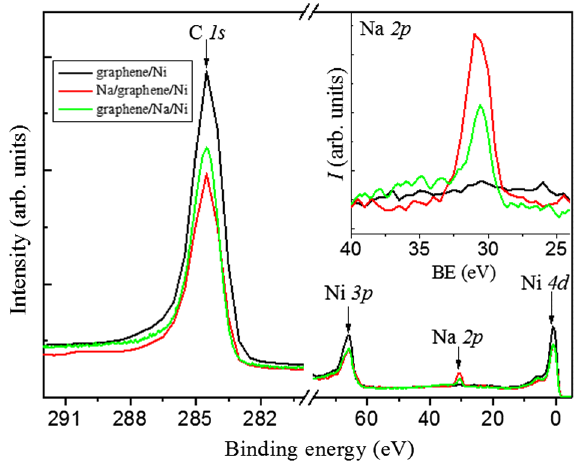
FIG. 8. Core-level PES spectra of the graphene grown on the Ni surface taken with a photon energy of 360 eV. The black, red, and green lines represent the PES spectra of the graphene/Ni(111) at − 140 °C, Na/graphene/Ni(111) at − 140 °C, and graphene/Na/ Ni(111) at þ 20 °C, respectively. The intensity ratio C 1 s /Na 2 p is 3.72 for the Na/graphene/Ni(111) at − 140 °C and 4.23 for the graphene/Na/Ni(111) at þ 20 °C, respectively. The inset depicts the Na 2 p PES spectra of the